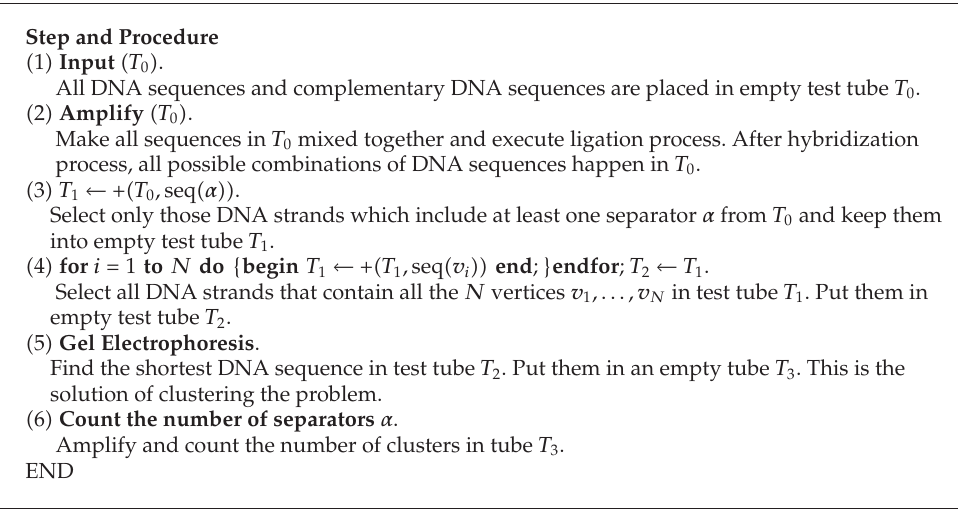
Algorithm 2: The DNA